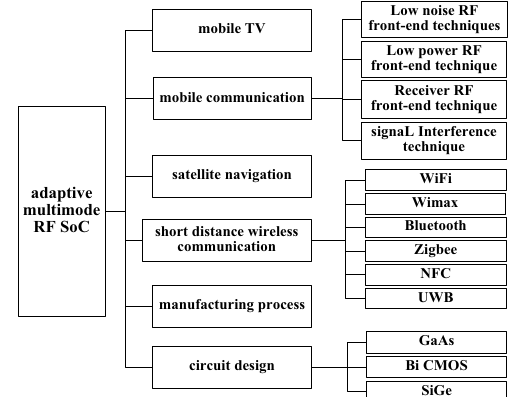
Fig . 3. An example of application-technical mixed taxonomy: a classification framework of the specific field of adaptable multimode RF system on chip (SoC).